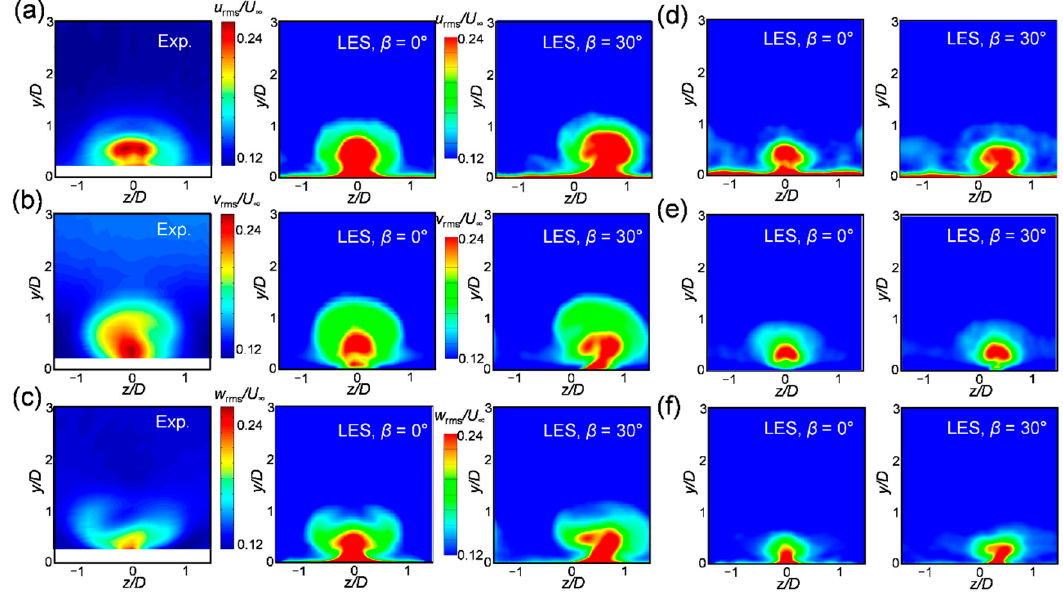
Figure 10. Turbulence intensities at x/D = 2.5 compared to those in the experiment of Burd et al. [32]: ( a ) u rms , M = 1.0; ( b ) v rms , M = 1.0; ( c ) w rms , M = 1.0; ( d ) u rms , M = 0.5; ( e ) v rms , M = 0.5; and ( f ) w rms , M = 0.5.